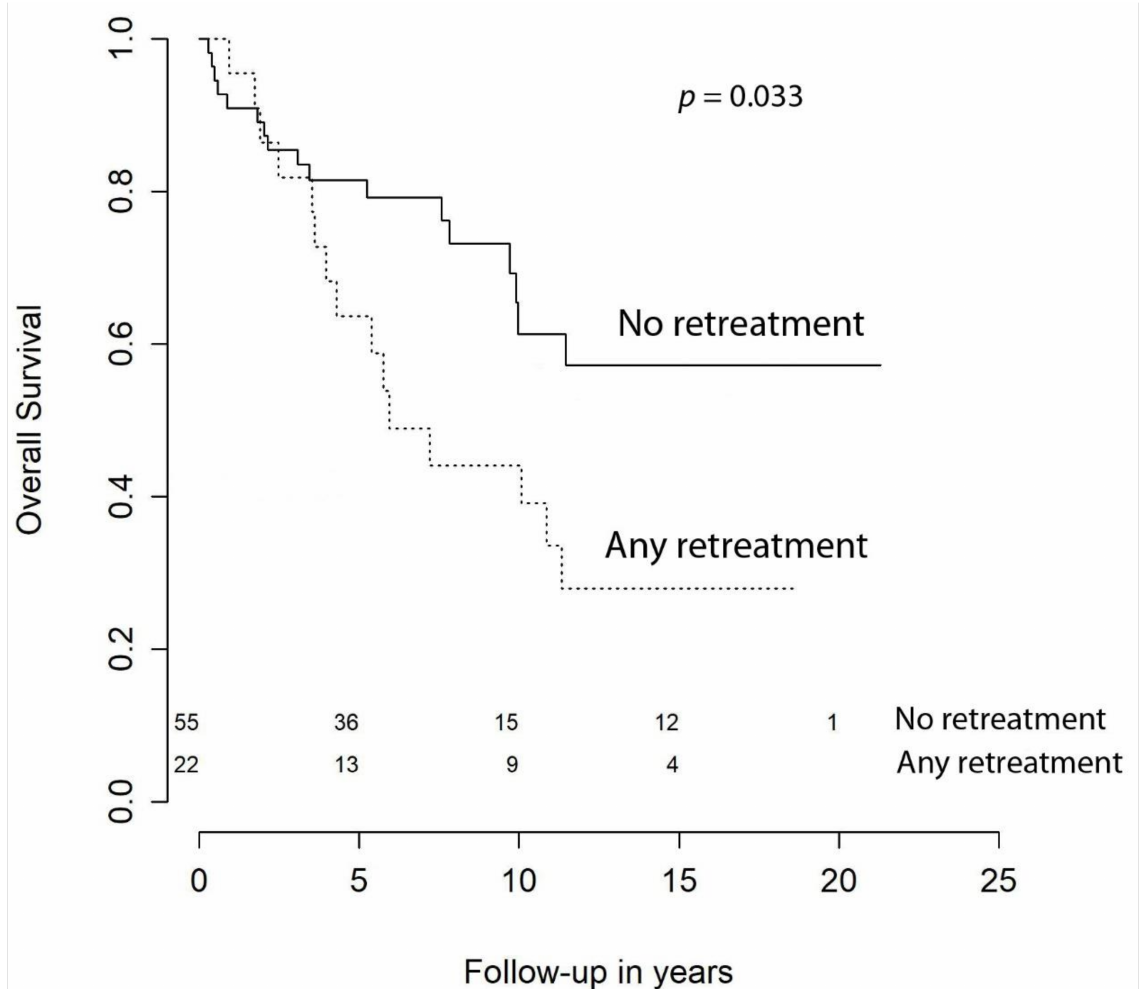
Figure 5. Overall survival by